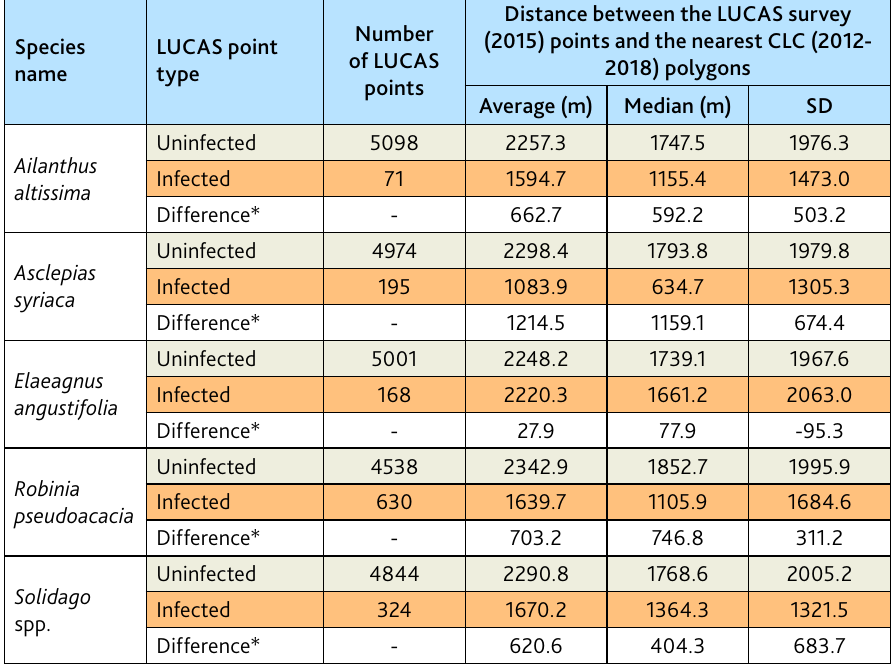
Table 1. Summary statistics of the Euclidean distances between the LUCAS survey (2015) points and the nearest CLC (2012-2018)